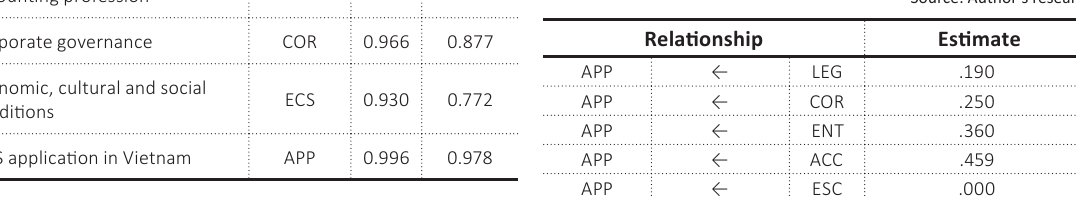
Table 6. Test parameters in the research